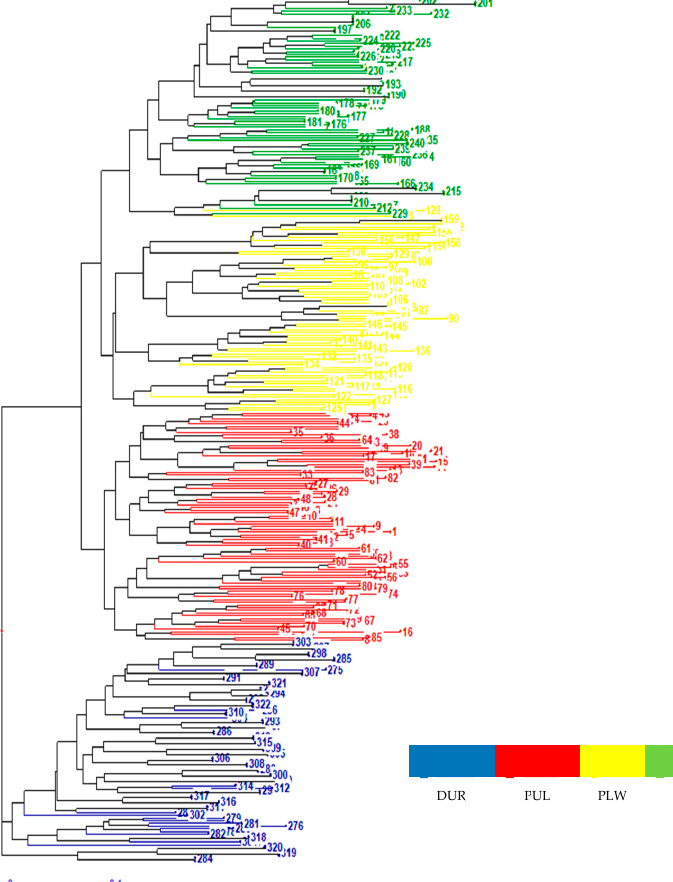
Figure 3. Genetic relationships among pigs with the use of a neighbor-joining tree obtained from a method based on genetic distance. PLW—Polish Large White; PL—Polish Landrace; PUL—Puławska Pig; DUR—Duroc.